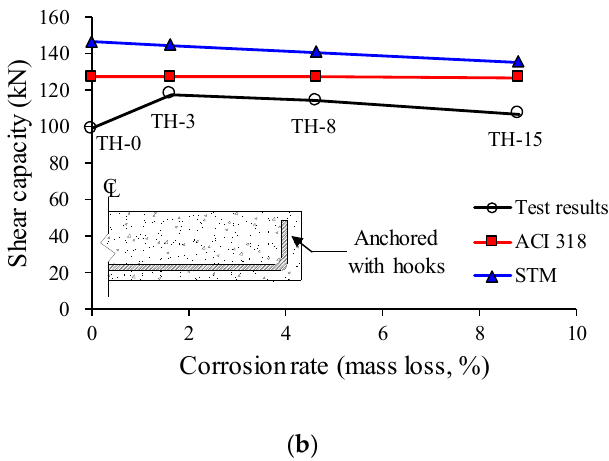
Figure 12. Comparisons of test and analysis results. ( a ) TS series specimens; ( b ) TH series specimens.